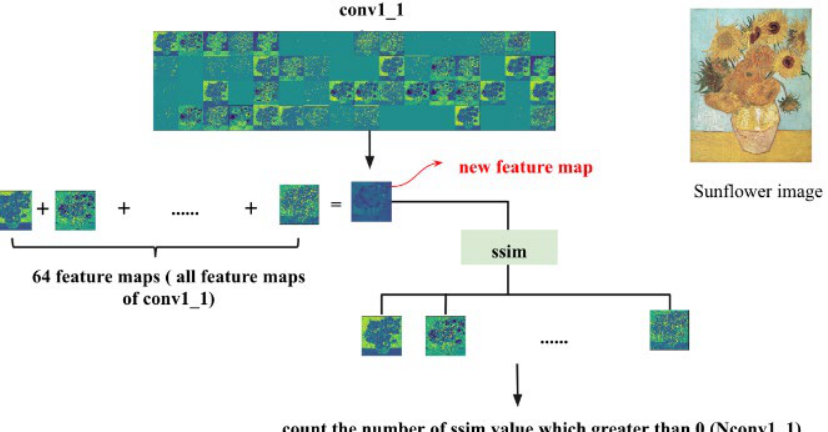
Figure 8. The process of comparing each feature map through SSIM.